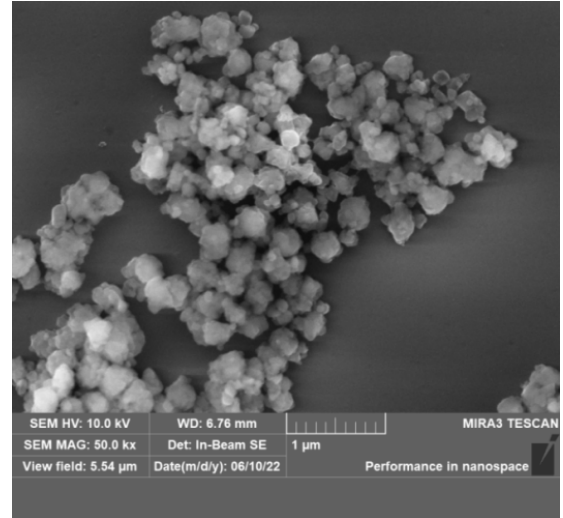
Figure 4. SEM images of the modified ZIF after aging.